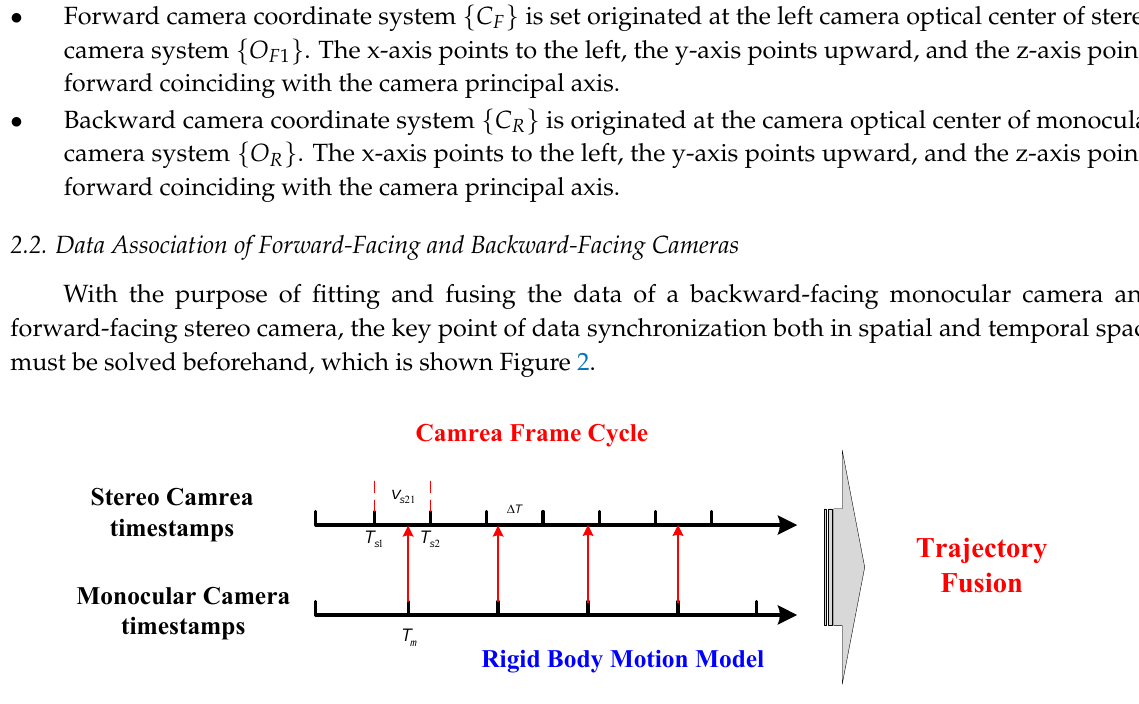
Figure 2. Rigid body motion model based trajectory data synchronization both in spatial and temporal space. [Color figure can be viewed at